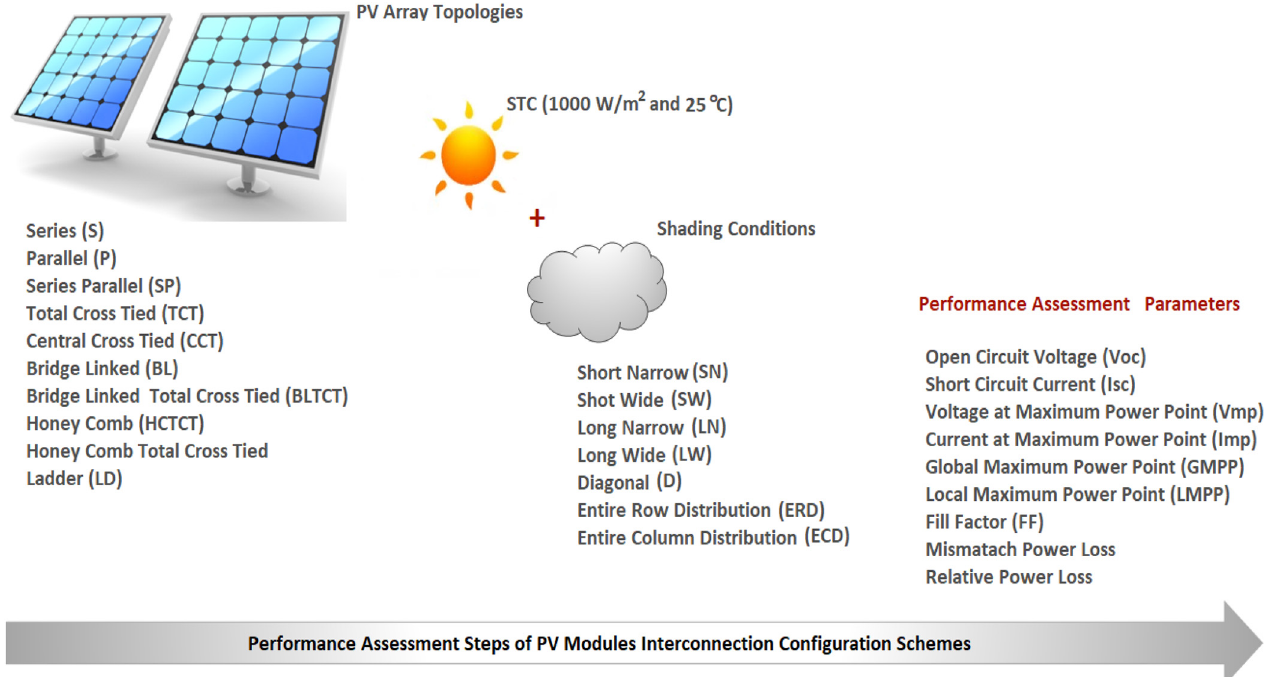
Fig. 3. PV modules interconnection con fi guration schemes, shading patterns and performance assessment parameters employed in this